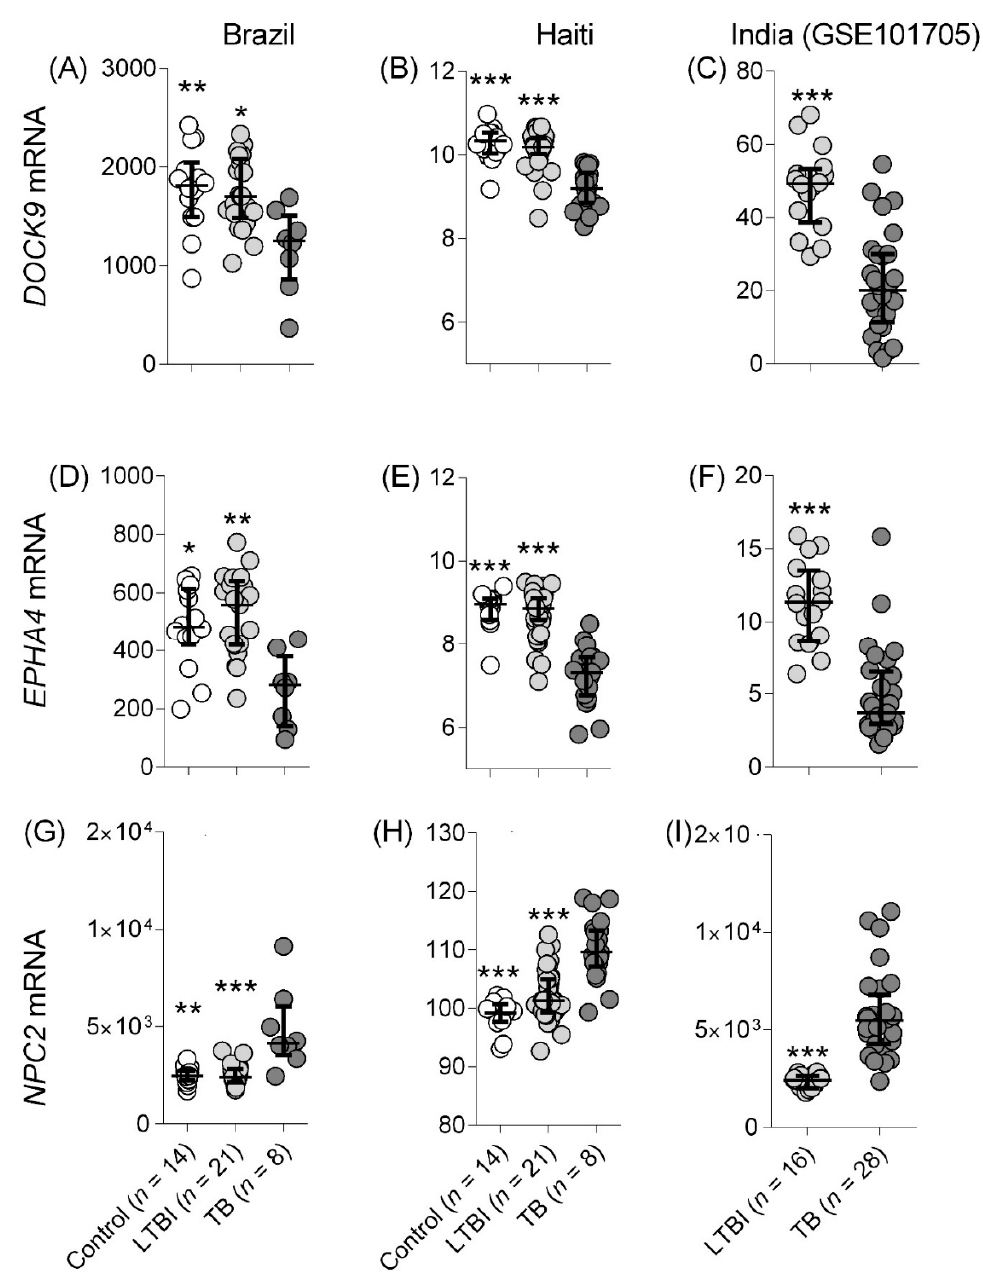
Figure 1. Individual normalized mRNA expression values of DOCK9, EPHA4 , and NPC2 mRNA in blood. Diagnostic groups comprise controls, latent tuberculosis infection (LTBI), and active tuberculosis (TB). ( A – C ) DOCK9 mRNA expression in cohorts from Brazil ( A ), Haiti ( B ), and India ( C ). ( D – F ) EPHA4 mRNA expression in cohorts from Brazil ( D ), Haiti ( E ), and India ( F ). ( G – I ) NPC2 mRNA expression in cohorts from Brazil ( G ), Haiti ( H ), and India ( I ).The Mann–Whitney test was used to assess significance between 2 groups. The Kruskal–Wallis test was used to assess significance of differences across more than 2 groups, followed by Dunn’s multiple comparison tests correction. * p -value < 0.05; ** p -value < 0.01; *** p -value < 0.005 with respect to TB.